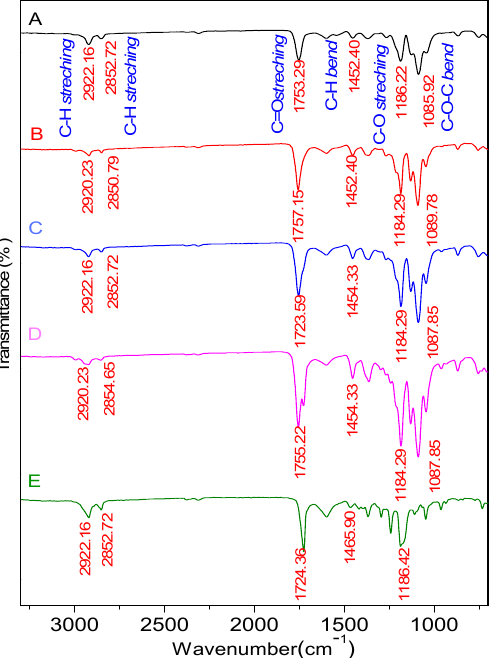
Figure 2. FTIR Spectrum of samples with composition of PLA:PCL; A (100:0), B (85:15), C (80:20), D (70:30), and E (0:100) in wt%. Table 1. FTIR data showing the functional groups of nanofiber